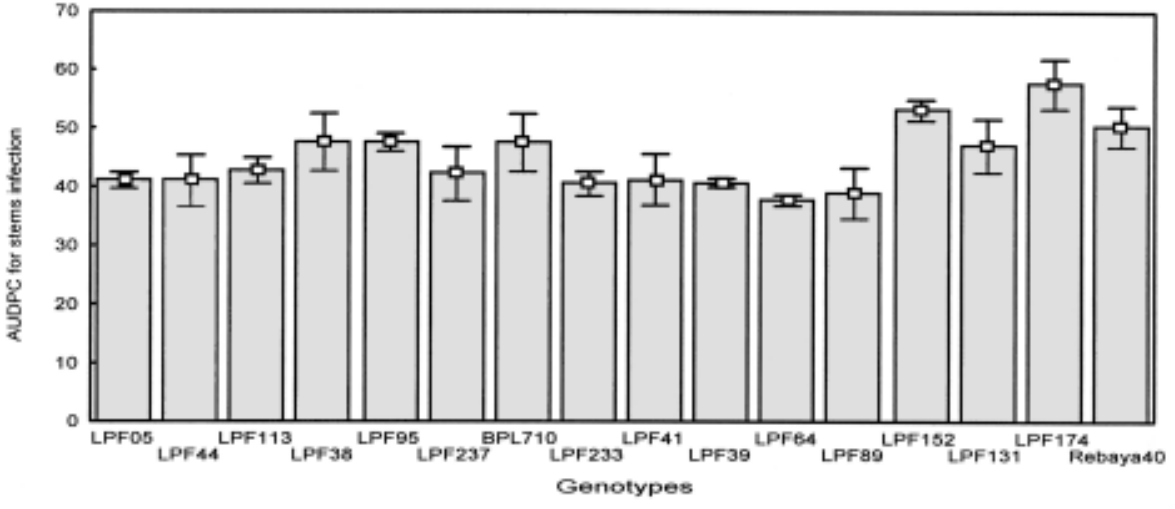
Fig. 5. AUDPC for stem infection of 16 genotypes of Vicia faba tested under greenhouse conditions and classified according to foliage infection. AUDPC values were calculated from the disease indexes on the stems (DIS), deter- mined 0, 7, 14, 21, 30, 37 and 52 days after inoculation, and ranged from 0 to 3. Bars represent standard